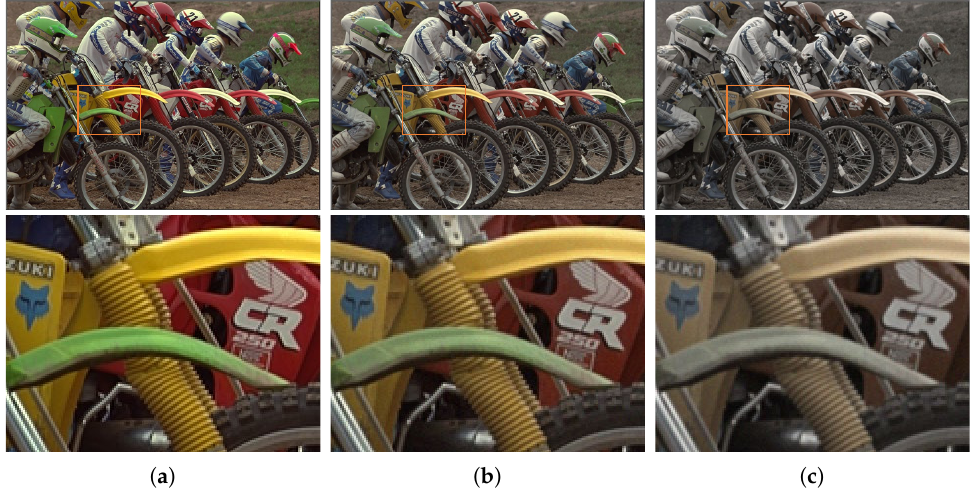
Figure 1. Problems of imaging under the crosstalk condition in CFA: ( a ) Original image; ( b ) degraded image by Gaussian kernel with σ g = 0.45 and noise with σ n = 0.01; ( c ) degraded image by Gaussian kernel with σ g = 0.6 and noise with σ n = 0.01. As the standard deviation σ g of the Gaussian kernel increases, desaturation and blurring intensify owing to interference with neighboring